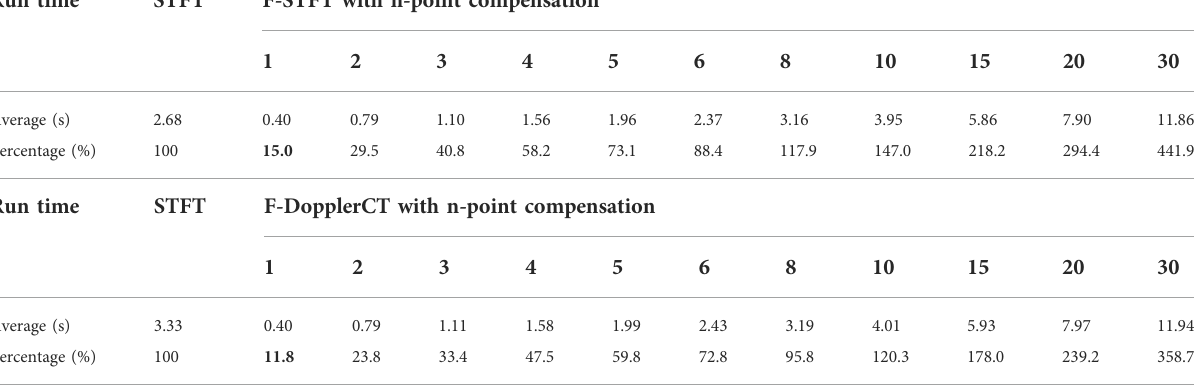
TABLE 1Average runtime ofcomputing TFDsofthe fi vetones. Thepercentageofruntime ofF-STFT andF-DopplerCT arecomputed referring tothe average run time of conventional methods STFT and DopplerCT. As the two bold numbers indicate, the average run time of